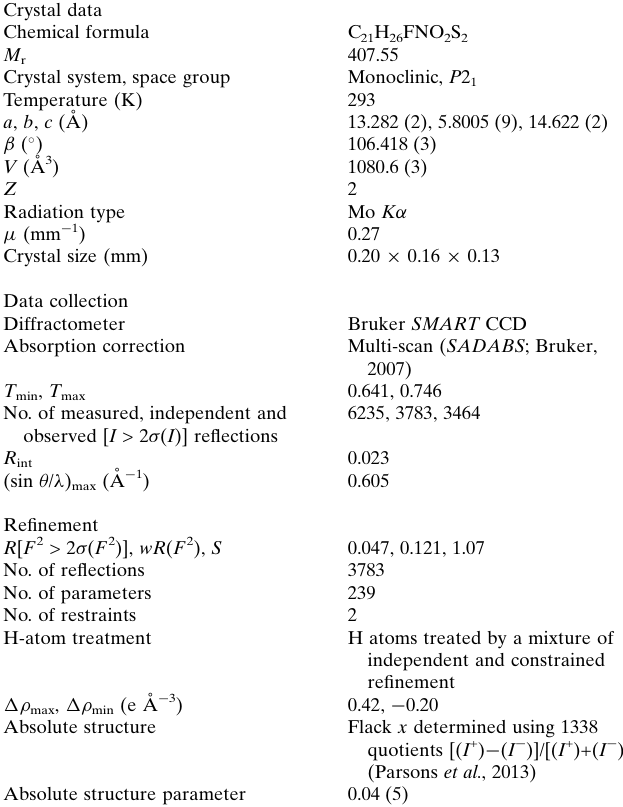
Table 2 Experimental details.